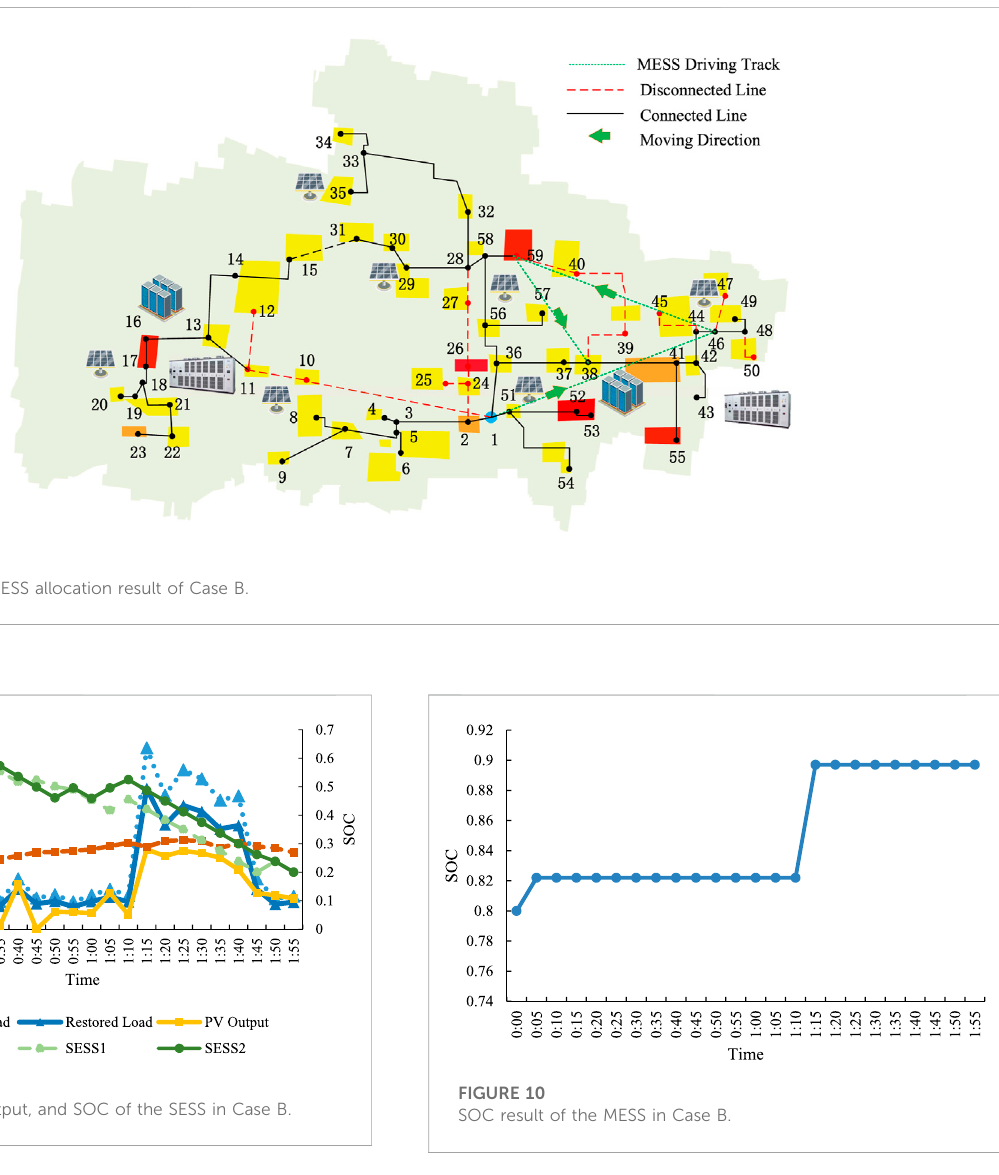
Figure 14; the load, PV, and SOC curves are shown in Figure 15.